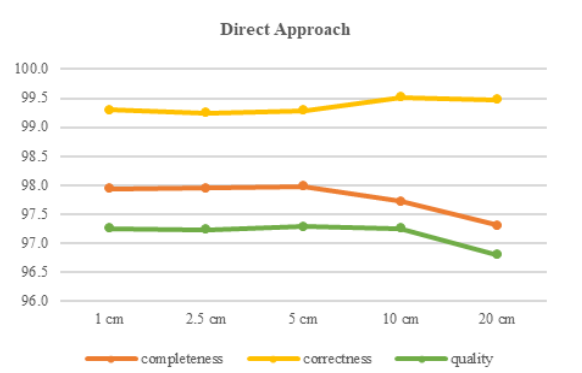
Figure 7. The quality measures of the extracted building outlines using the direct approach for five different point cloud densities: 1 cm, 2.5 cm, 5 cm, 10 cm, and 20